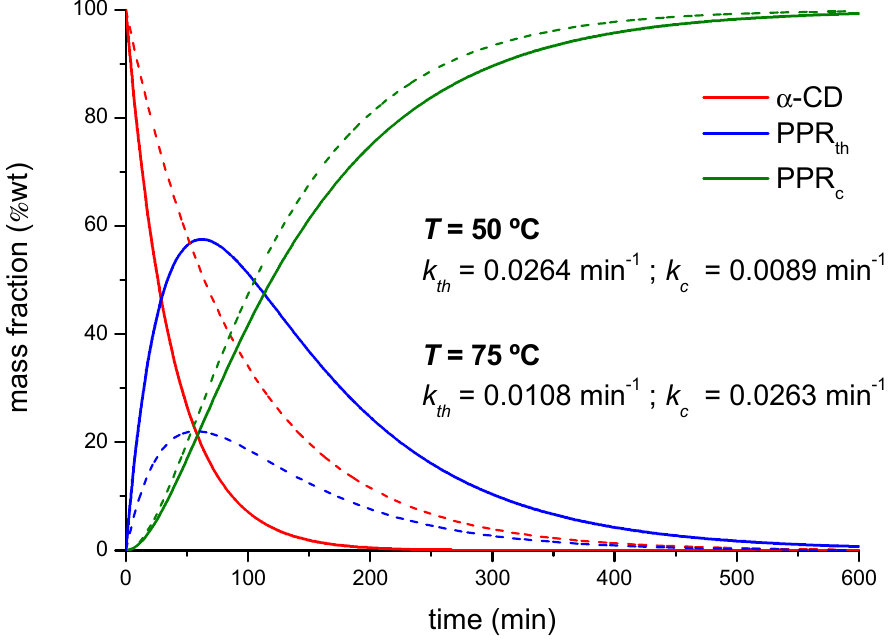
Figure 6. Calculated mass fractions of the different species in the reaction between PEG400 and α -CD, 1:1 reaction feed at 50 ◦ C (dotted lines) and 75 ◦ C (solid lines).